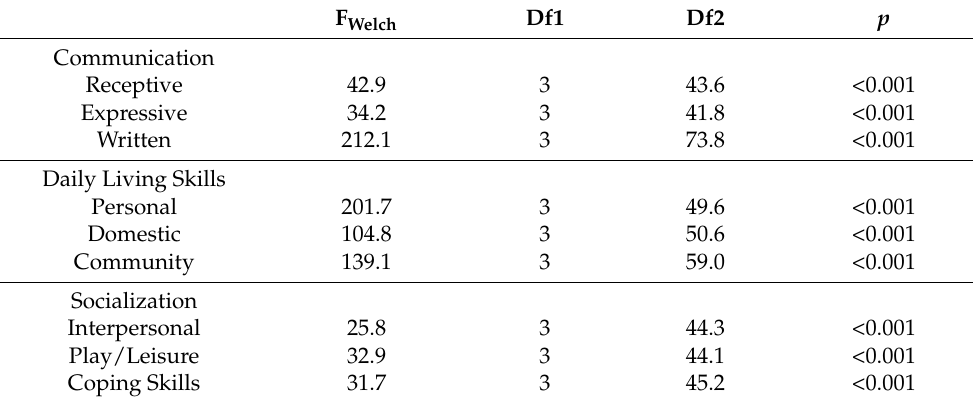
Table 3. Group (Level of ID) differences between subdomains of